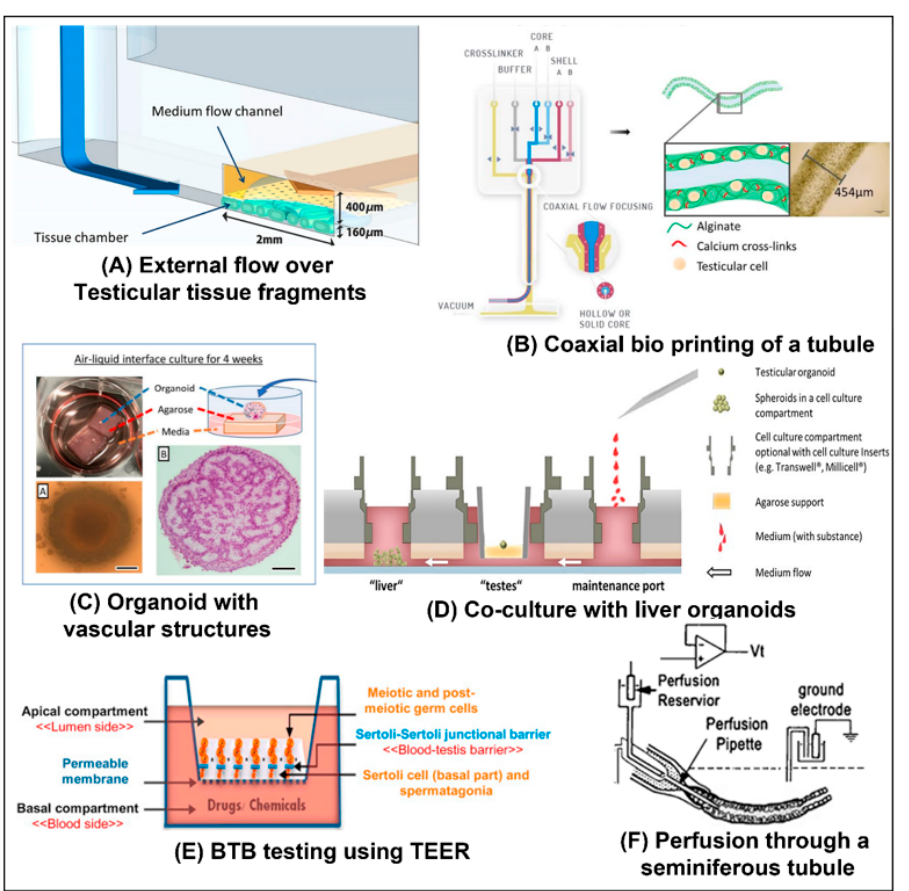
Figure 7. In vitro spermatogenesis implementations: ( A ) An organ culture approach was used. Testicular tissue fragments are cultured below a membrane and fresh media is continuously flowed over the membrane. The culture could be maintained for as long as six months [50]. Reproduced